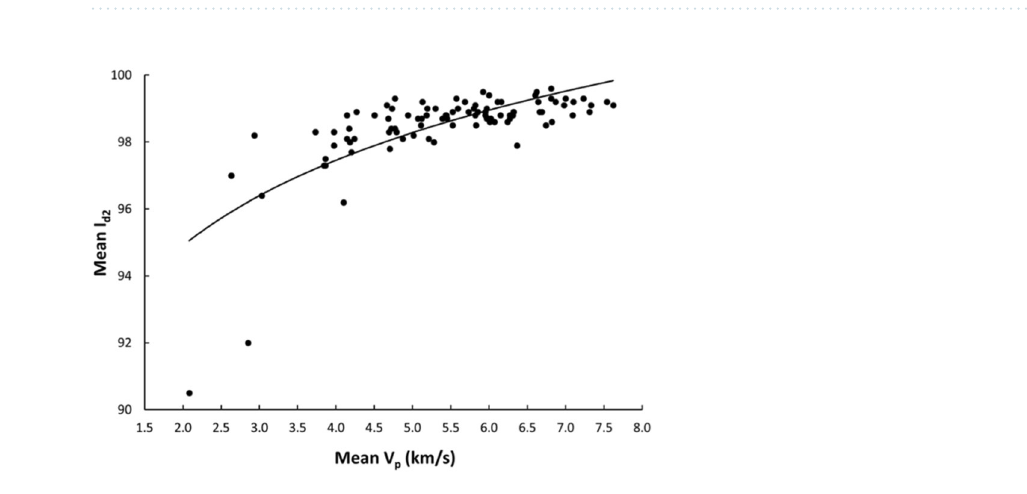
Figure 6. Relationship between the V p and PLI (I s(50) ) of limestone.